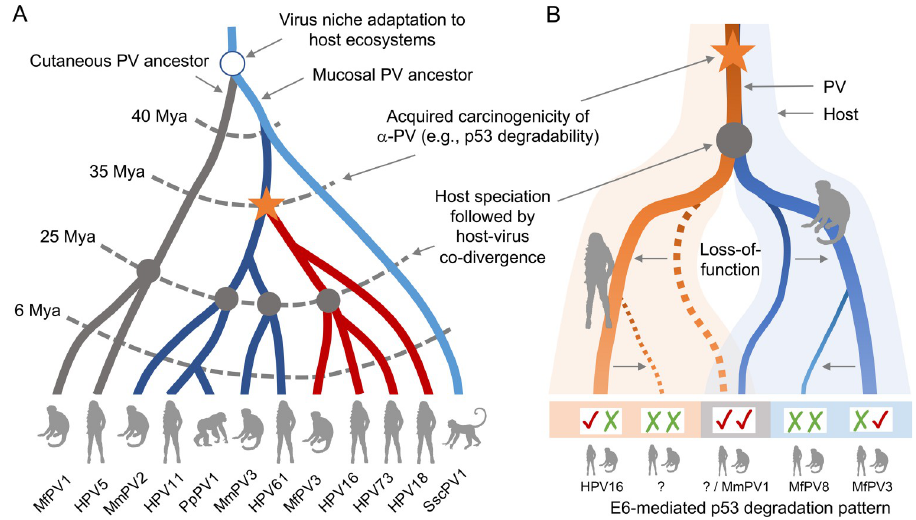
Fig 6. Schematic diagram of a loss-of-function mutation model for the differential abilities of high-risk primate PV E6s to promote p53 degradation. (A) Ancient niche adaptation of primate PV ancestors to different host ecosystems (e.g., mucosal vs cutaneous) followed by the emergence of carcinogenic PVs (branches in red) and subsequent host speciation events. Divergence times (million years ago, Mya) refer to previous publications [7,8]. Representative PV types are indicated at the end of branches. (B) Function loss of acquired viral phenotype following host speciation and viral niche adaptation. This loss-of-function mutation model may be responsible for the formation of a host species barrier or even defective phenotype. Broken lines represent clades in which specific monkey PVs lack detectable human counterparts. Patterns of high-risk primate PV E6-mediated p53 degradation are shown at the pp p ” indicates cross-host p53 degradation mediated by primate PV E6; “ X” indicates host- bottom of the figure. “ p specific human p53 degradation mediated by HPV E6; “X ” indicates host-specific monkey p53 degradation mediated macaque PV E6; and “XX” indicates defective p53 degradation mediated by PV E6.